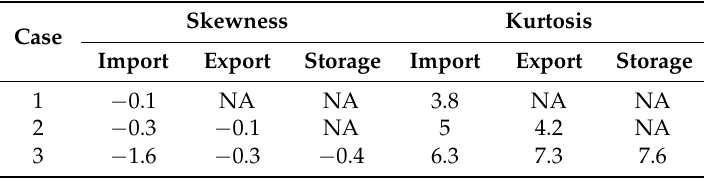
Table 2. Statistical parameters of Cases 1, 2, and